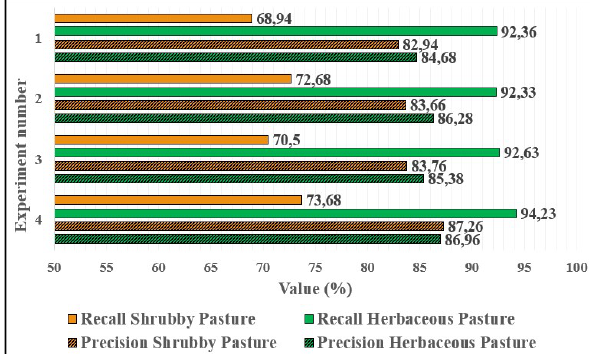
Figure 3: Average values of Precision and Recall for both classes considering each one of the four experiments.